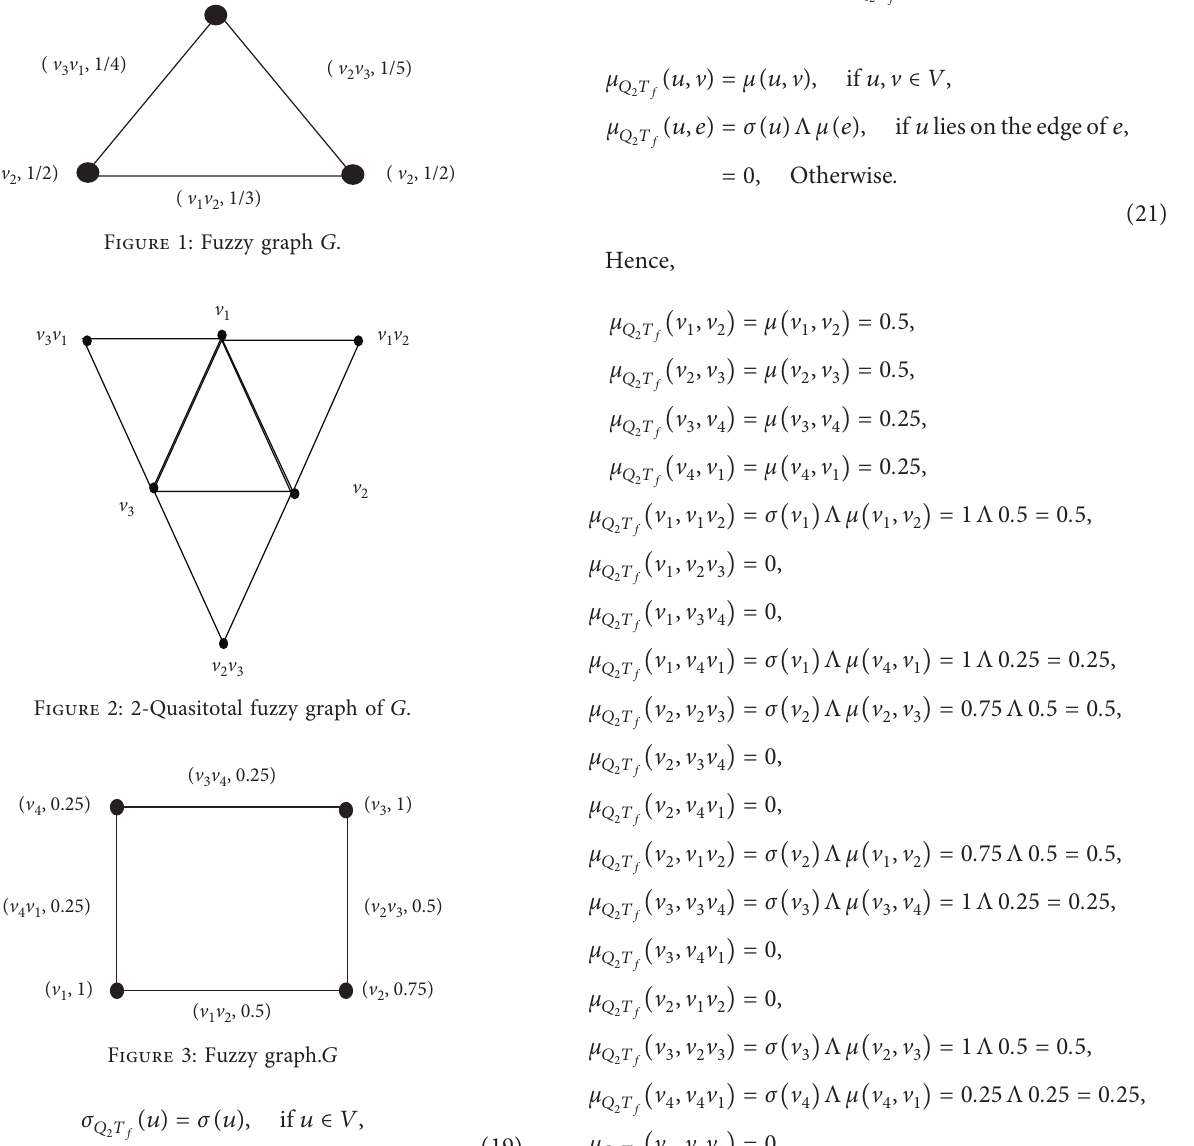
Figure 3: Fuzzy graph.